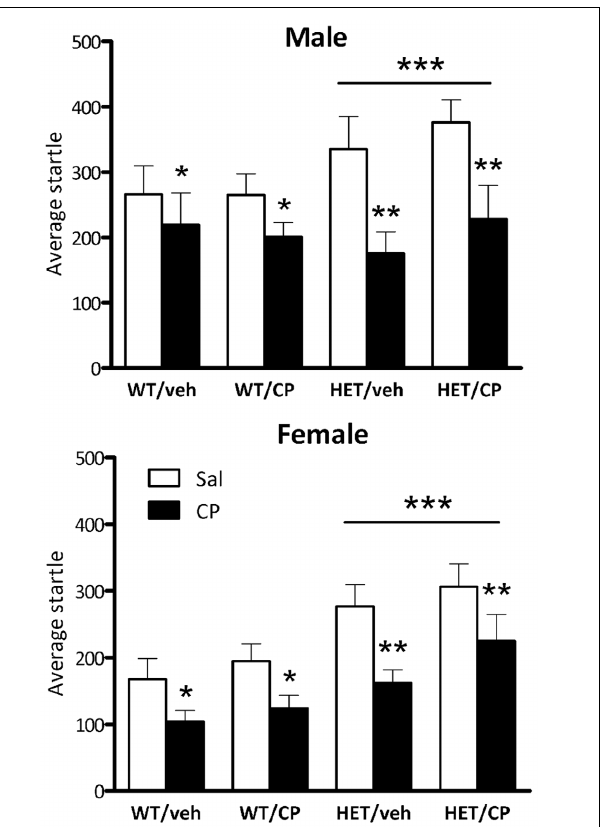
FIGURE 6 | Average startle amplitude in the four treatment groups: WT/veh, WT/CP, HET/veh, and HET/CP in both sexes. All groups were administered saline (Sal; open bars) and 0.4mg/kg CP55,940 (CP; black bars). Data are mean ± SEM. ∗ P < 0 . 05 for difference with saline based on ANOVA main effect. ∗∗ P < 0 . 05 for greater effect of acute CP injection in HET mice based on ANOVA CP × genotype interaction. ∗∗∗ P < 0 . 05 for difference in startle amplitudes between WT and HET mice based on ANOVA main